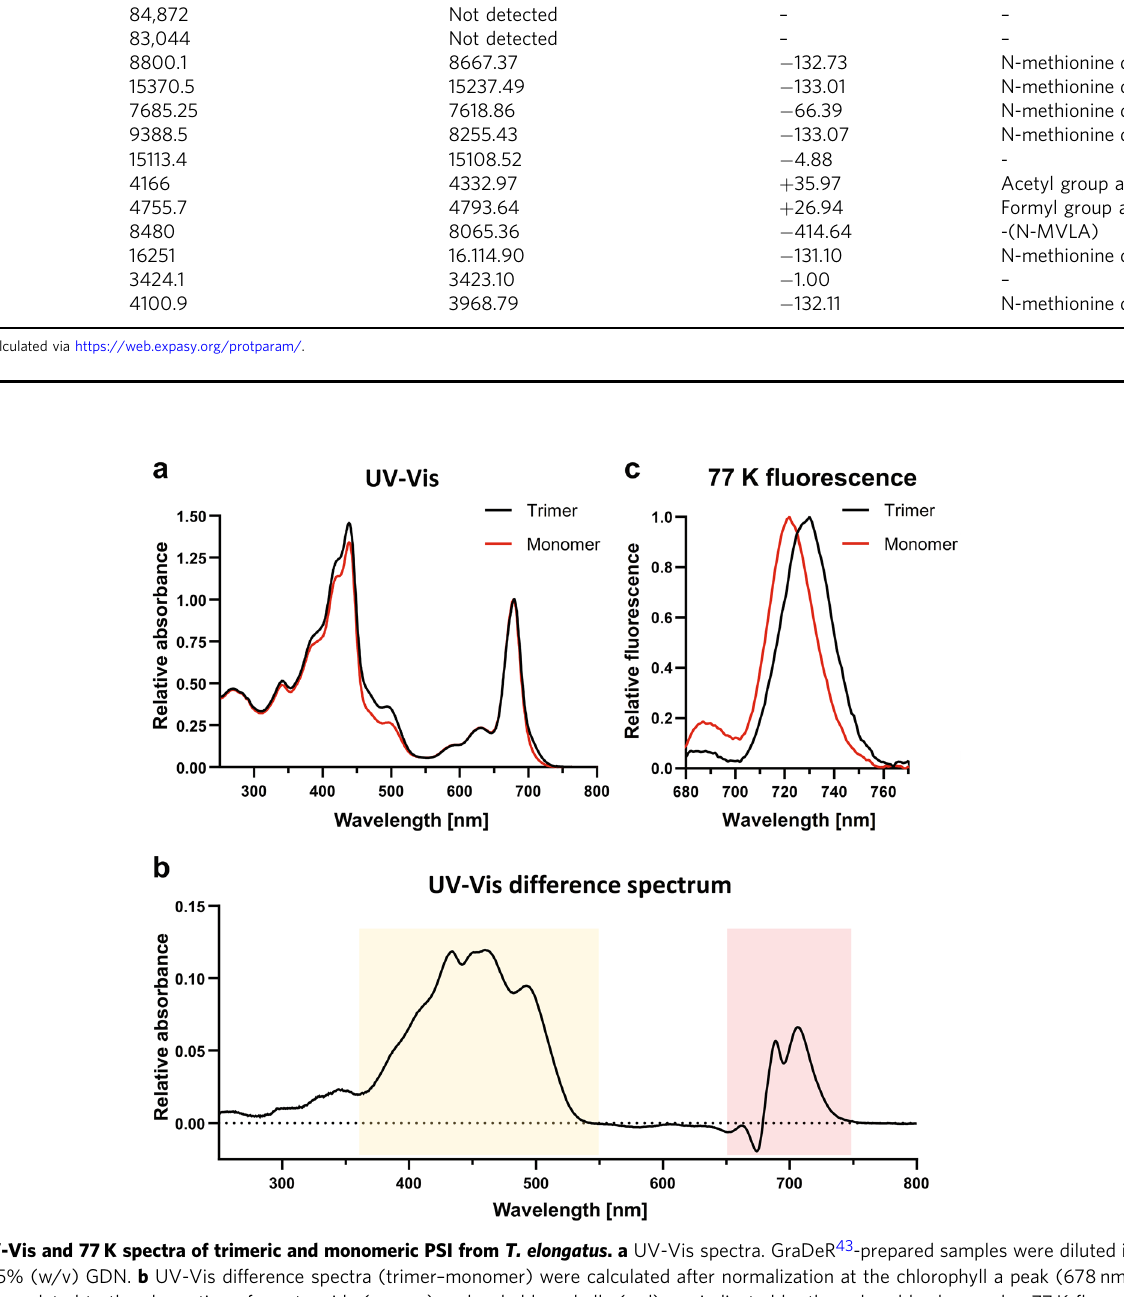
Table 2 for data collection and re fi nement statistics and Supplementary Table 1 for the percentage of modeled amino